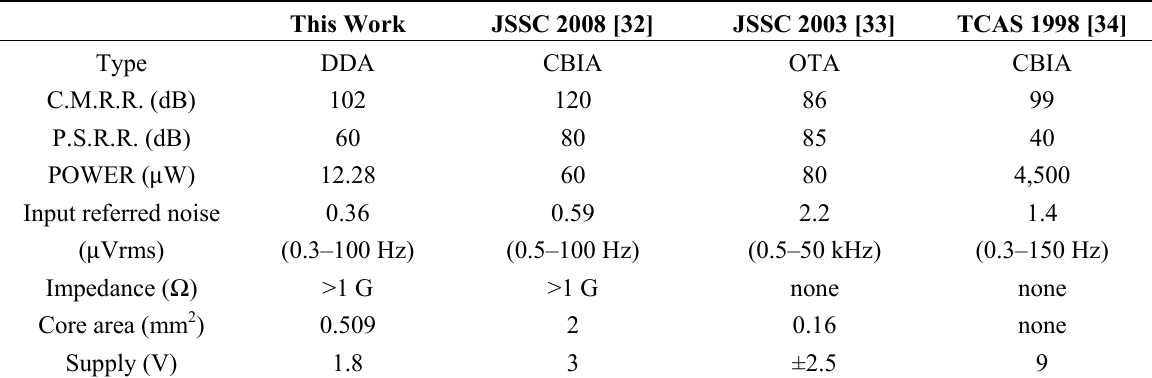
Table 2. Performance summary of the DDA